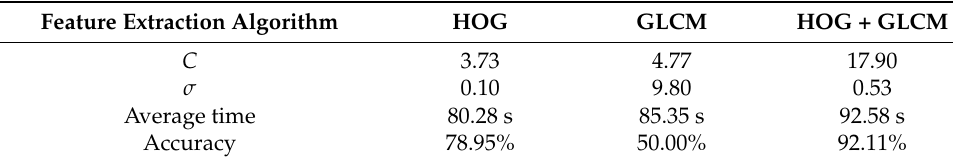
Figure 9. Comparison of image segmentation results of insulator example images. ( a ) Segmentation of normal insulator images. ( b ) Segmentation of defective insulator images. Table 4. Classification performance of three features in